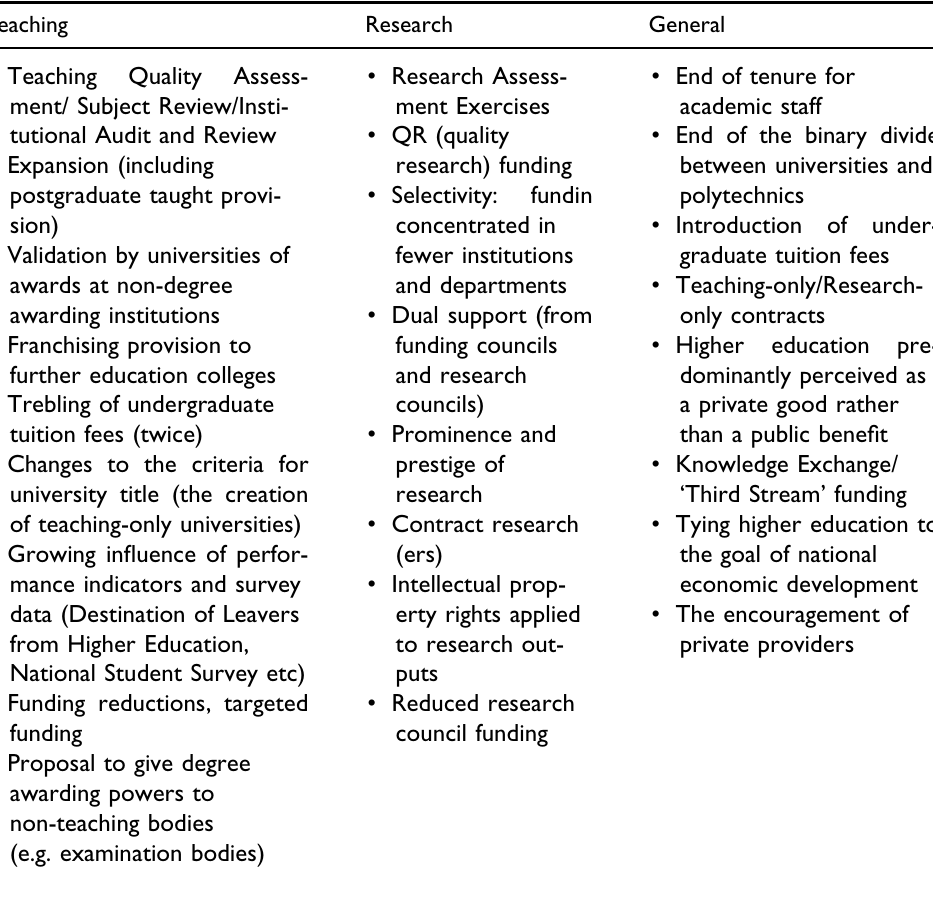
Table 1. Key factors in the teaching–research